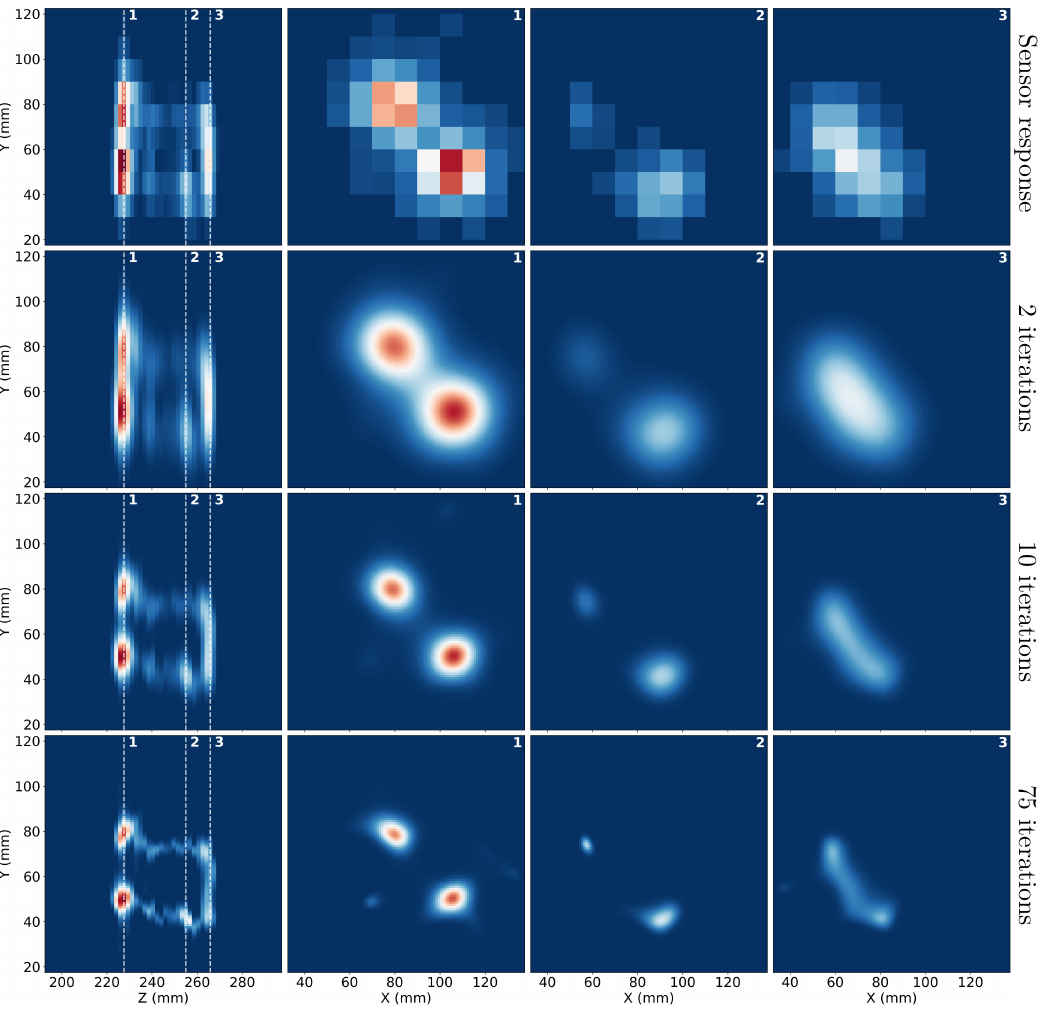
Figure 8 . Effect of successive RL iterations (2, 10 and 75) in three selected slices. The event is an electron-positron pair (from